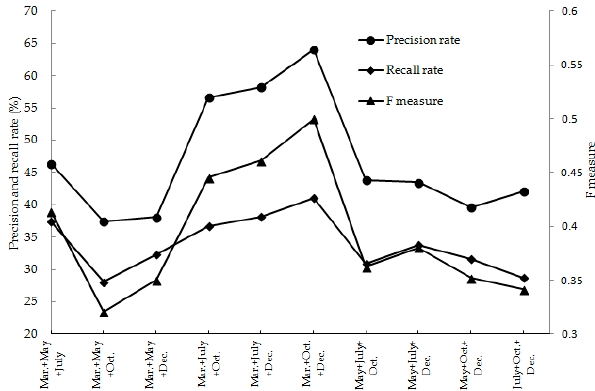
Figure 9. Precision rate, recall rate, and F measure values for the QVP detection from the ten combined three-season datasets.